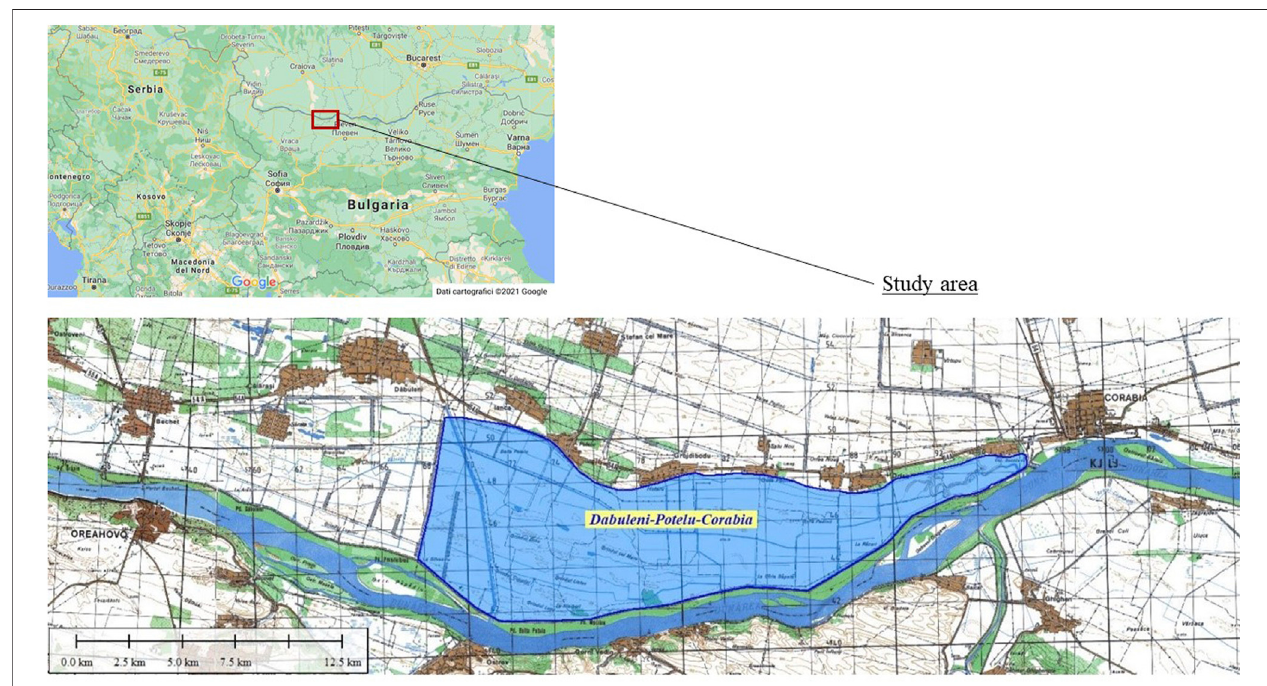
FIGURE 3 | Location of the study